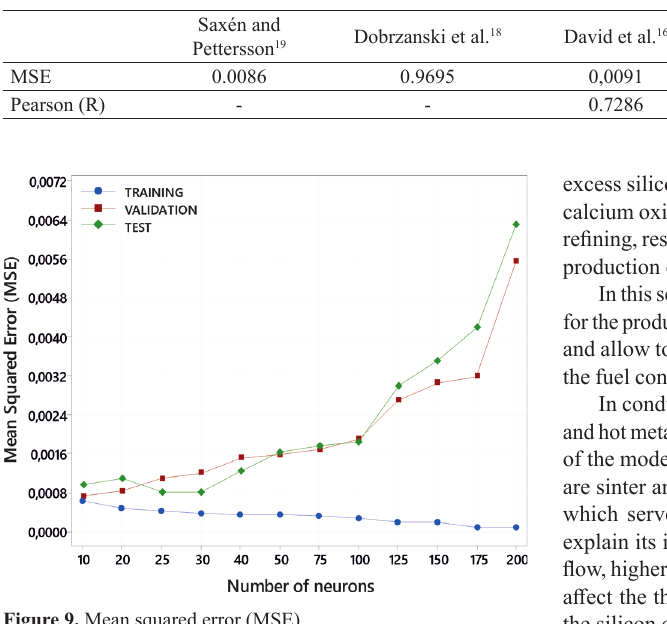
Figure 9. Mean squared error (MSE).